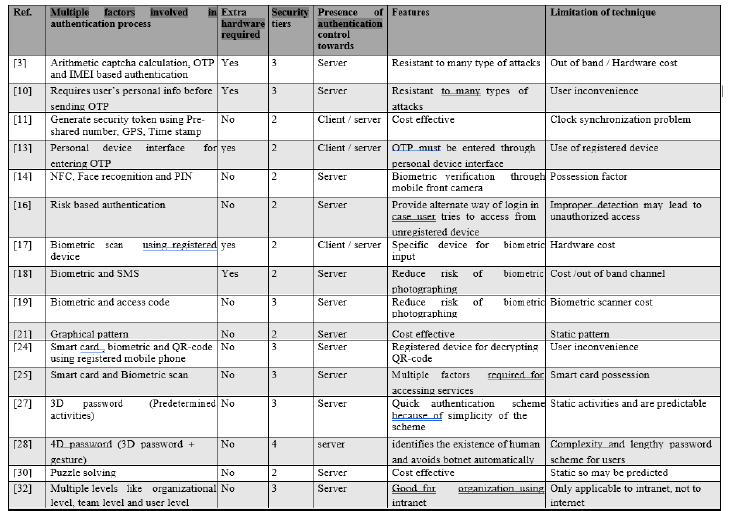
TABLE 1 Comparison of various multitier